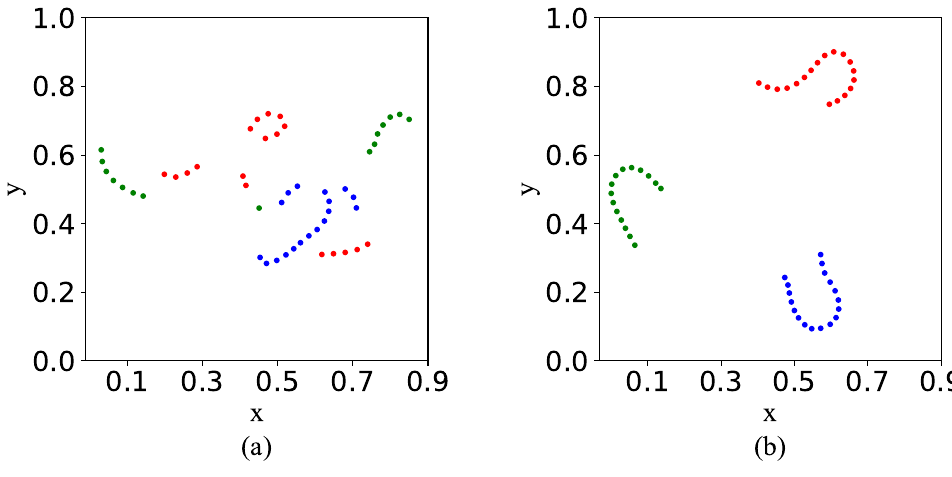
Figure 6. Dots with different colors indicates features belonging to different videos. ( a ) Without FTS loss. ( b ) With FTS